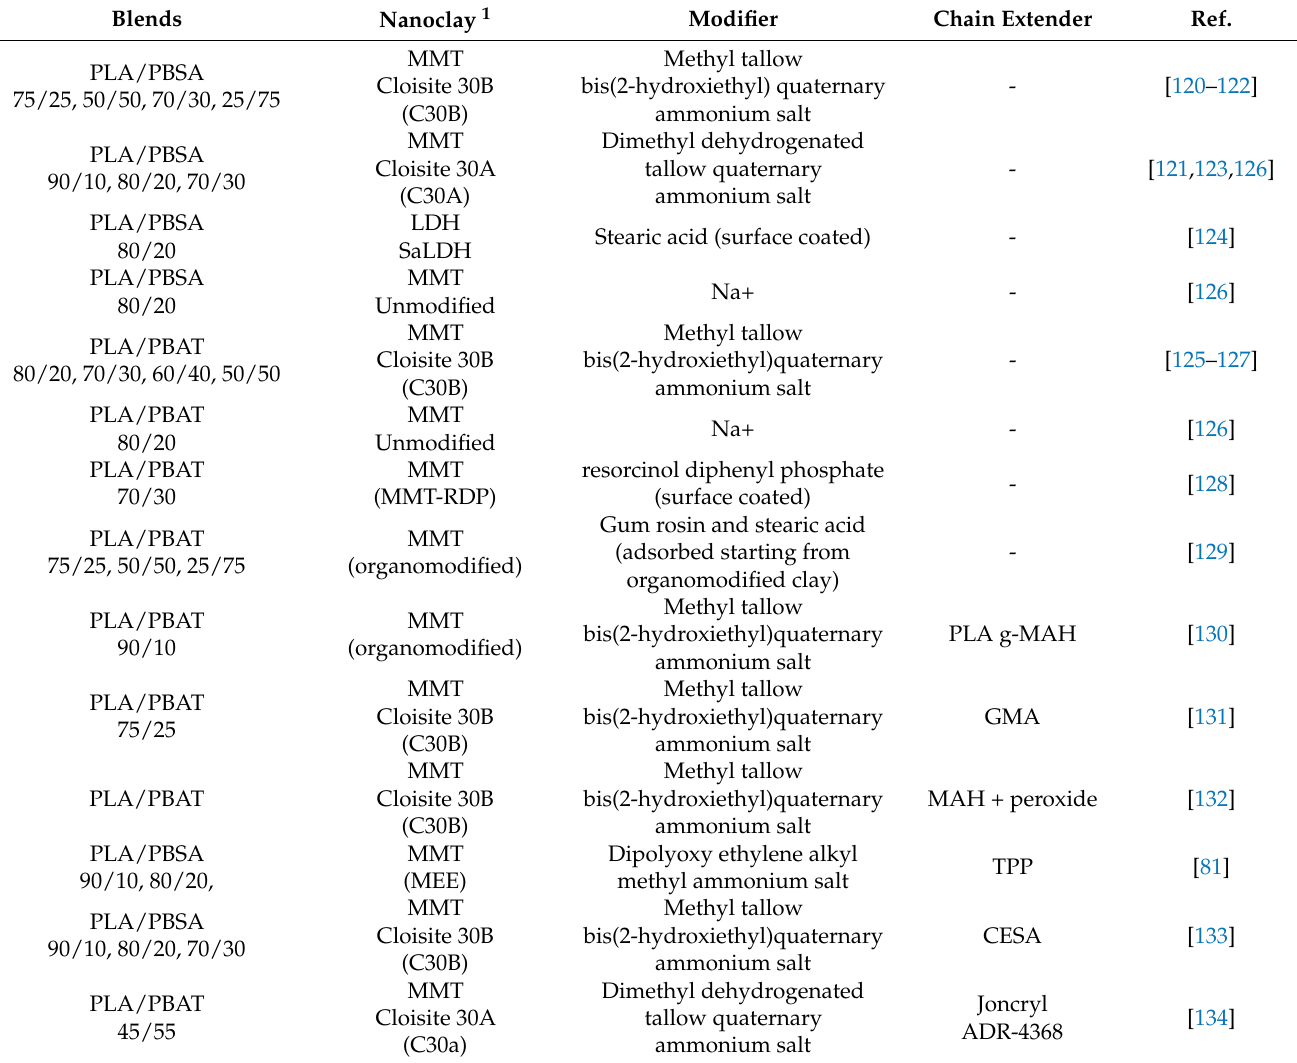
Table 4. Type of nanoclay and blends composition used for preparation of PLA/PBSA or PLA/PBAT nanocomposites. Blends Nanoclay 1 Modifier Chain Extender